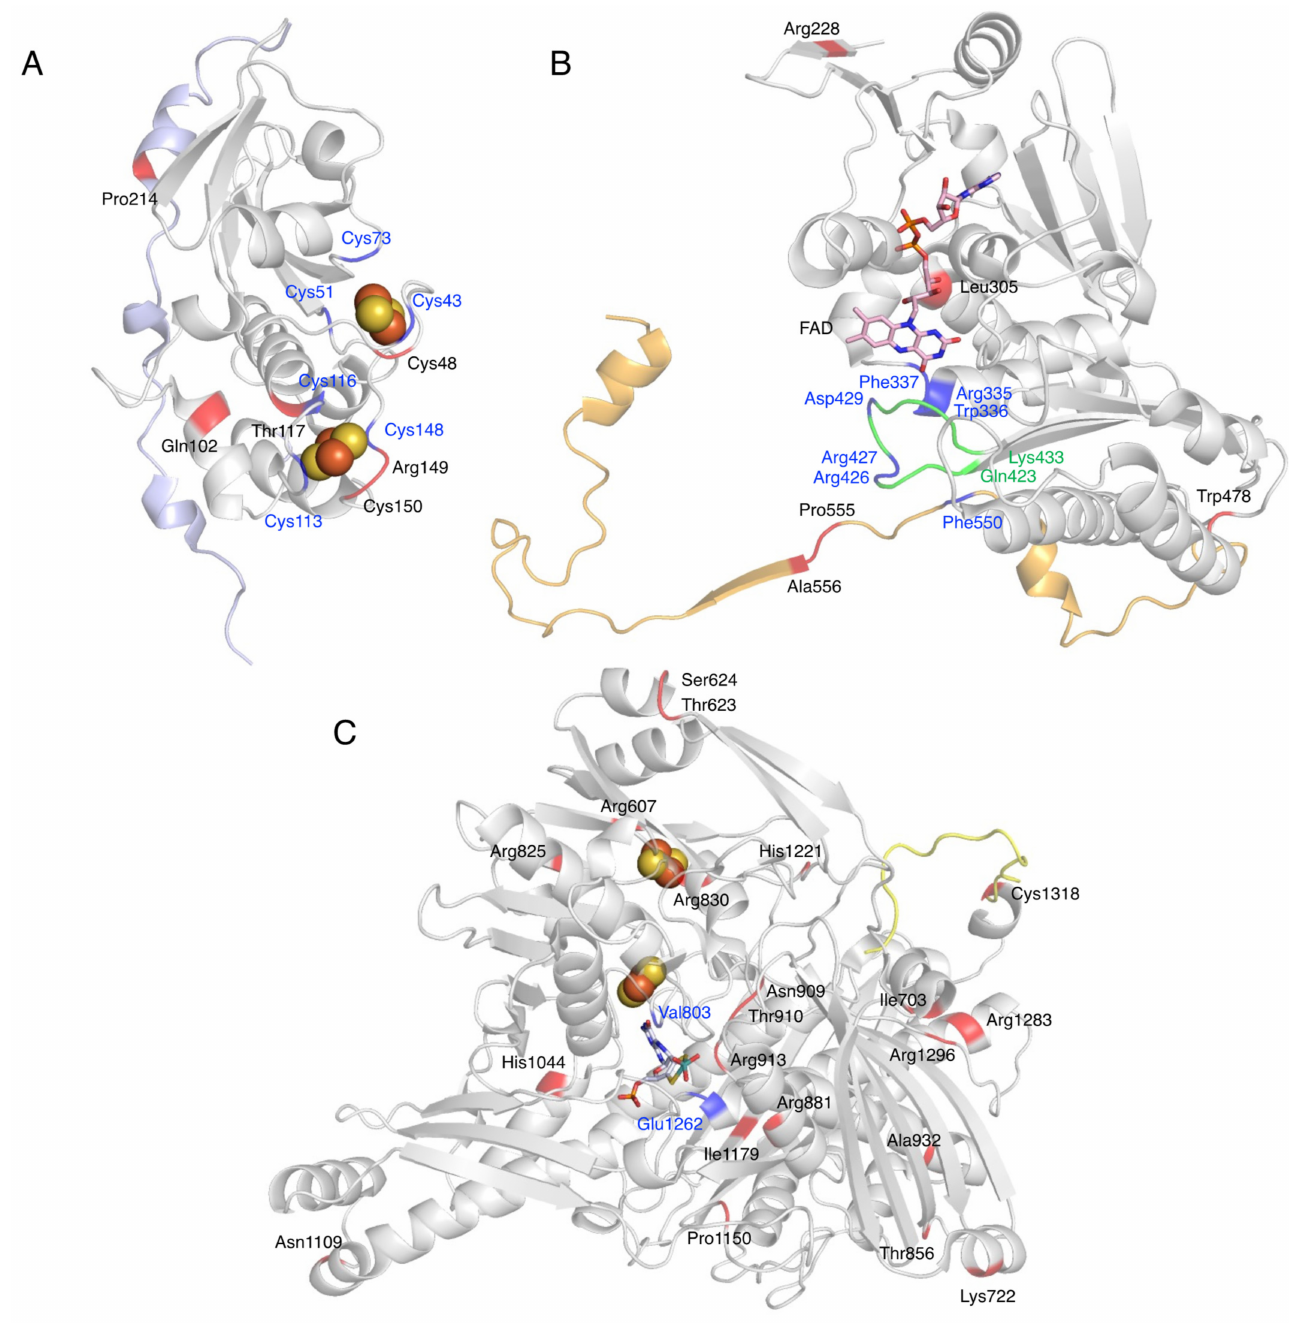
Figure 7. Mutation sites of XOR. Fe/S domain ( A ), FAD domain ( B ), and Moco domain ( C ) of human XOR are shown as a ribbon model. The linker between the Fe/S domain and the FAD domain is shown in light blue ( A ), the linker between the FAD domain and the Moco domain is shown in orange ( B ), and the C-terminal peptide is shown in yellow ( C ). Blue indicates amino acid residues that are important for enzyme function. Mutation sites are shown in red. Green indicates the A-loop consisting of